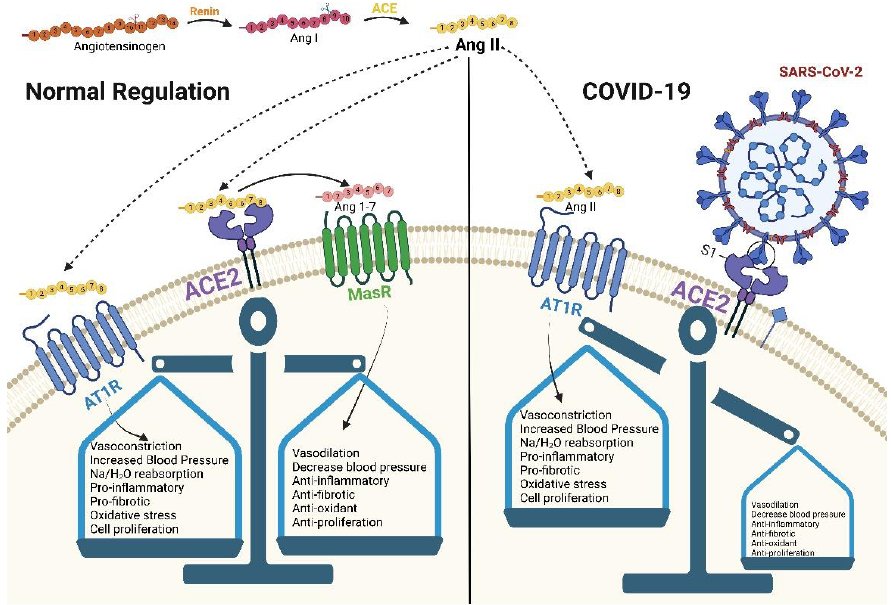
Figure 1. SARS-CoV-2 blocks ACE2 causing RAAS dysregulation. Created with BioRender.com.